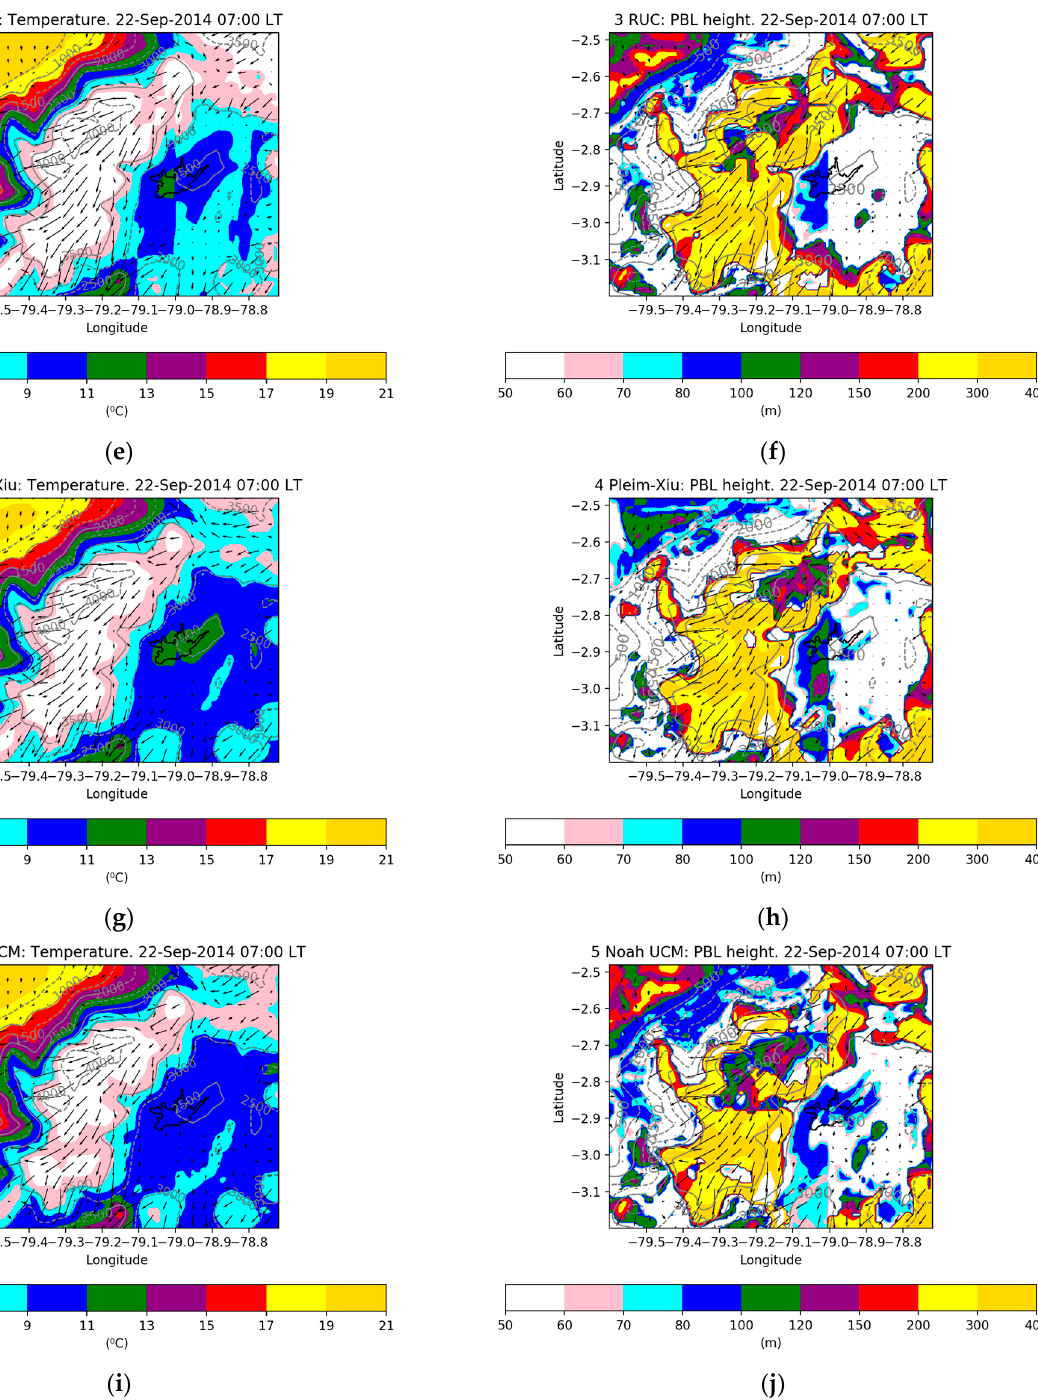
Figure 4. Modeled temperature and planetary boundary layer height on 22 September 2014 (07:00 LT): ( a , b ) 1 5-Layer; ( c , d ) 2 Noah; ( e , f ) 3 RUC; ( g , h ) 4 Pleim–Xiu; ( i , j ) 5 Noah UCM.